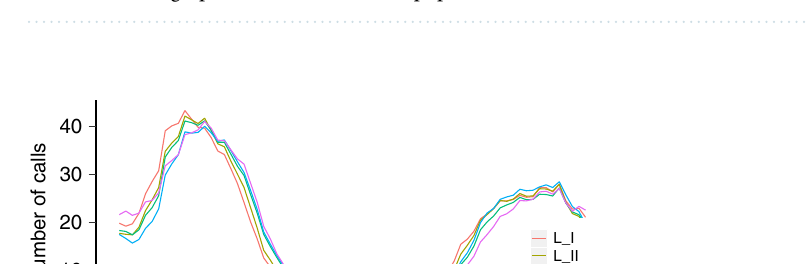
Table 1. Demographic information of the population.